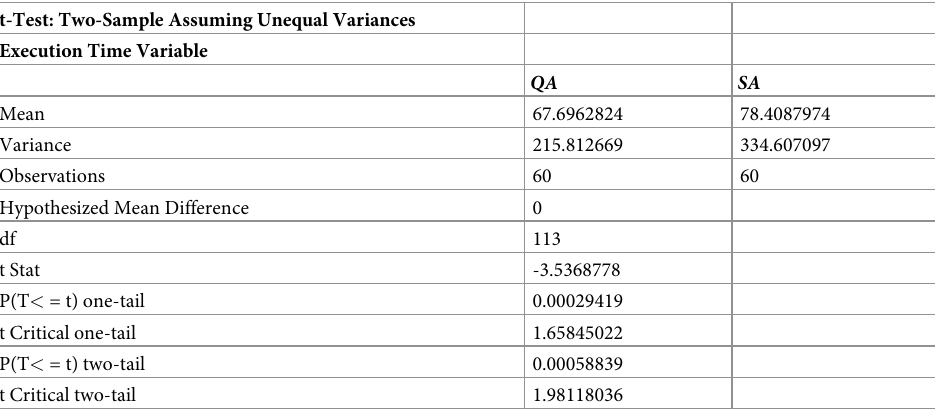
Table 21. T-test for n = 50 nodes and N = 60 trials—execution time variable. t-Test: Two-Sample Assuming Unequal